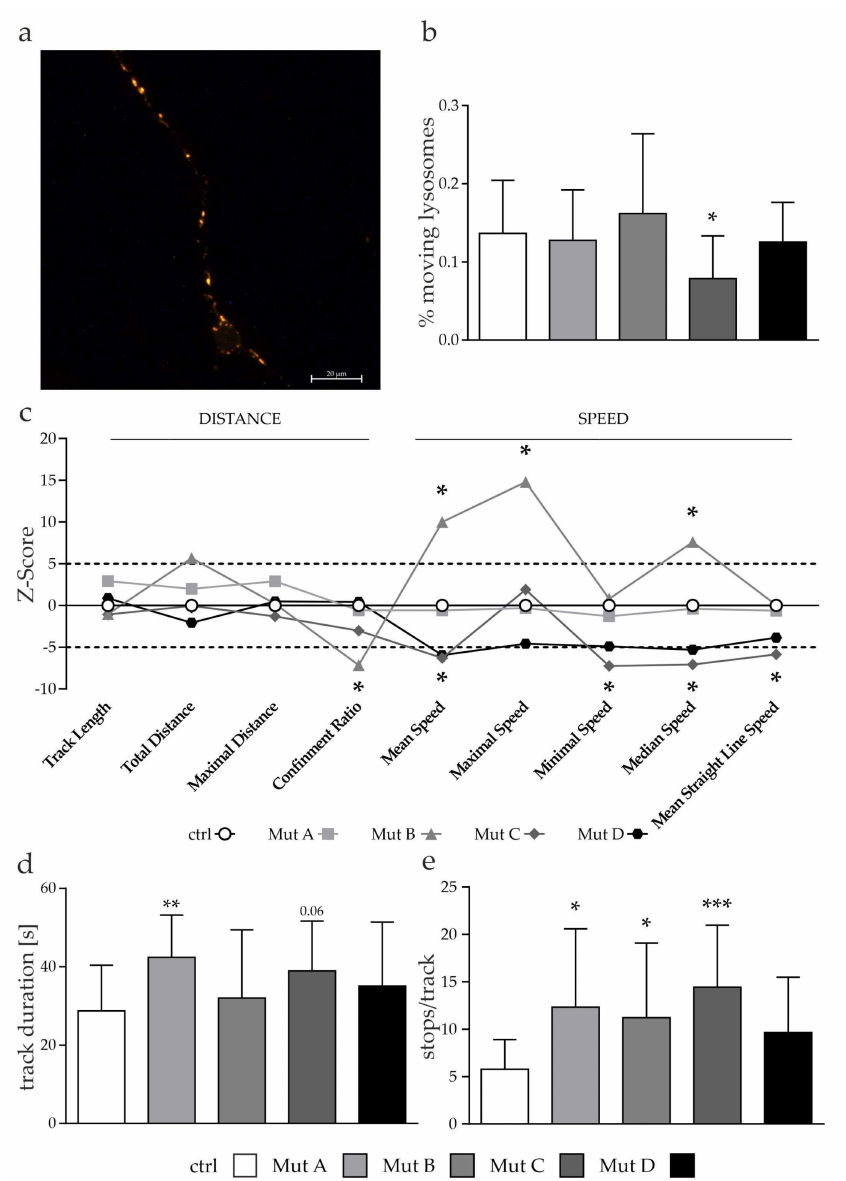
Figure 6. Analysis of lysosomal transport. ( a ) Example picture of cells transduced with the CellLight TM BacMam 2.0 technology for lysosomes. Scalebar = 20 µ m. ( b ) The percentage of moving lysosomes was reduced in one NPC1-deficient cell line. ( c ) Z-score for each of the speed and distance parameters was calculated using the formula in Section 2.3. A Z-score higher than 5 and lower than –5 was defined as significantly different from the control cell line (dashed lines). The symbols of the individual parameters are connected with a line. This was not intended to indicate any relationship between the individual parameters, but only serves to improve the interpretability of the data presented. The traveled distance seemed not to be affected. Two cell lines showed a reduced and one cell line an increased speed, whereas the transport of this cell line was less efficient (Confinement Ratio). ( d ) Bar graph of the track duration showed a significant increase in Mut A and C. ( e ) Bar graph of the calculated amount of stops/track. All NPC-deficient cell lines showed a significantly increased number of stops. Graphs in ( b ), ( d ), and ( e ) show mean ± SD with N = 4, n = 15–17. One-way ANOVA and Dunnet’s multiple comparison post hoc test were used to determine statistical significance, with * = p < 0.05, ** = p < 0.01, *** = p < 0.001. ctrl = control cell line. Mut A (NP-C1): c.1180T>C; Mut B (NP-C1): c.1836A>C/c.1628delC; Mut C (NP-C1): c.3182T>C; Mut D (NP-C2):